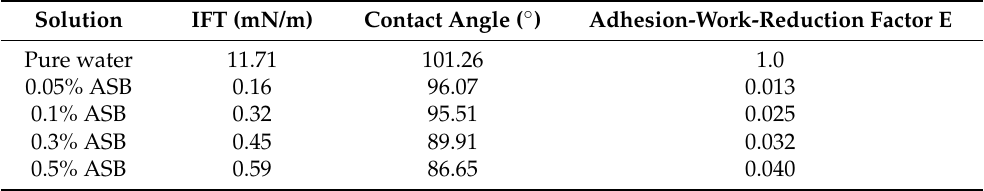
Table 4. Adhesion-work-reduction factor E of ASB surfactant with different